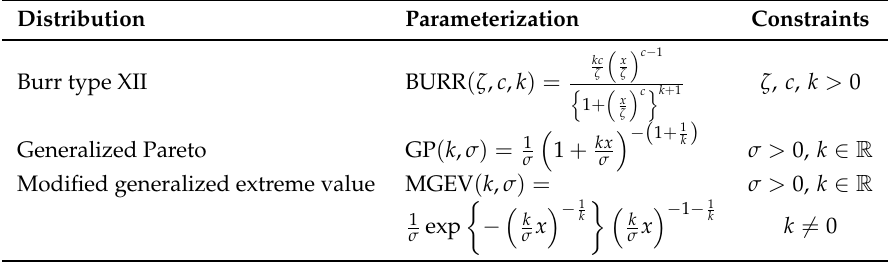
Table 1. Parametric severity distributions considered, defined on the non-negative real